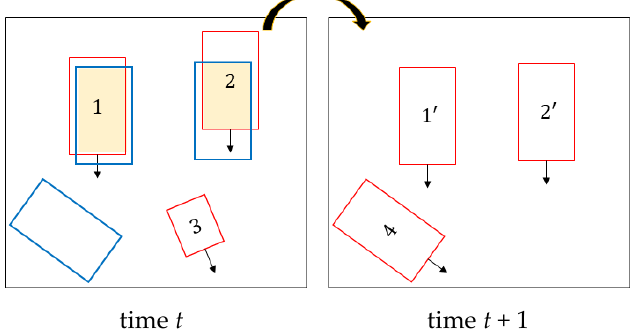
Figure 4. Data association between the detection result and the set of objects being tracked at time t in multi-object tracking (blue boxes are objects detected at t , red boxes are objects being tracked at time t + 1: 1 and 2 were tracked, 3 was deleted, and 4 is a new object).